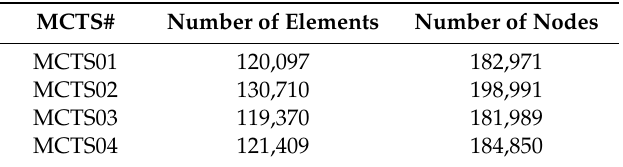
Table 2. Mesh density based on the number of elements and